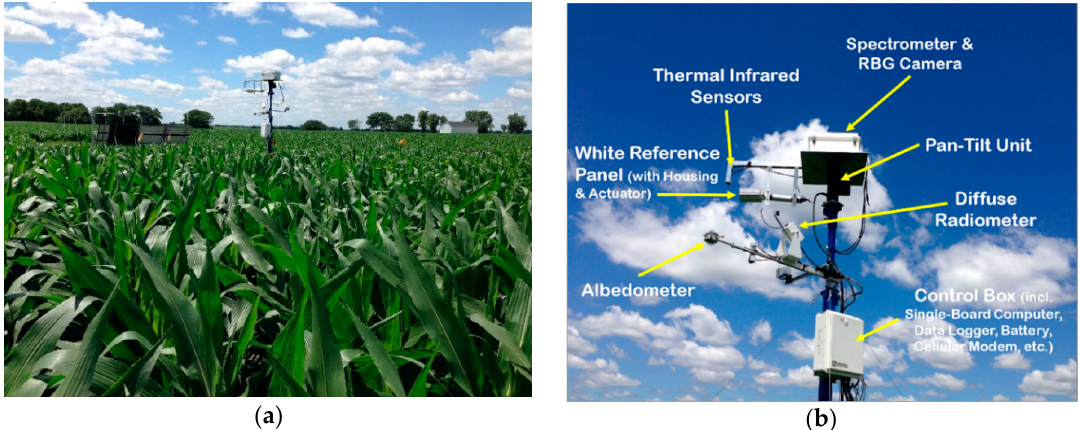
Figure 1. EcoSpec system. ( a ) The system installed in a corn field (2016) powered by solar energy and ( b ) system components. Table 1. EcoSpec System Sensors and Components.